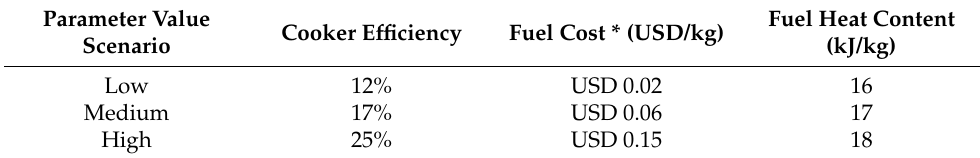
Table 3. WC MLCOE input parameters for calculation of the cost distribution in the WC low-cost